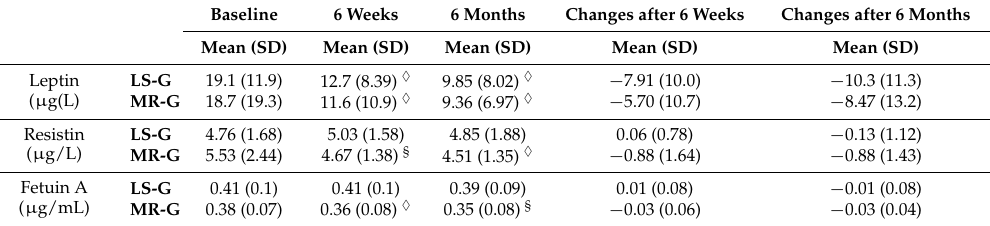
Table 3. Plasma levels of the adipokines Leptin, Resistin and Fetuin A during the course of the study. Mean ˘ standard deviation (SD). LS-G, lifestyle intervention group; MR-G, meal replacement group. §, p < 0.05 compared to baseline; ♦ , p < 0.01 compared to baseline (paired T -Test).Differences between the intervention groups (ANOVA) were not significant at any point of the